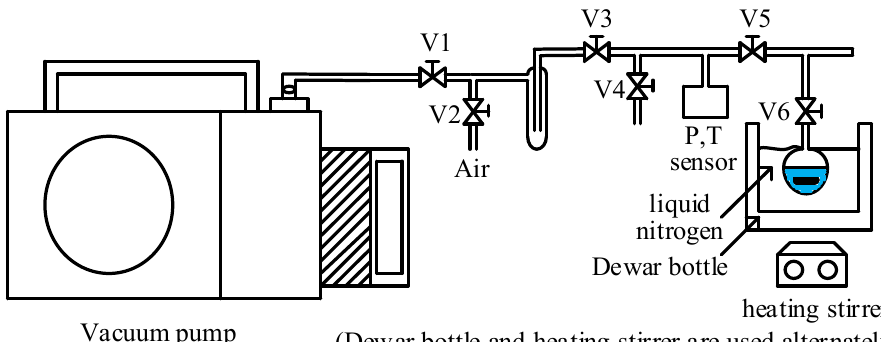
Figure 1. Measuring system for vapor pressure.